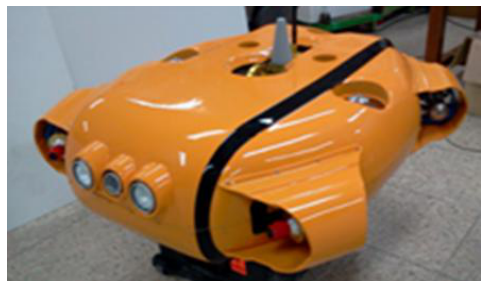
Figure 4. The developed 6-DOF of the unmanned underwater vehicle (UUV).